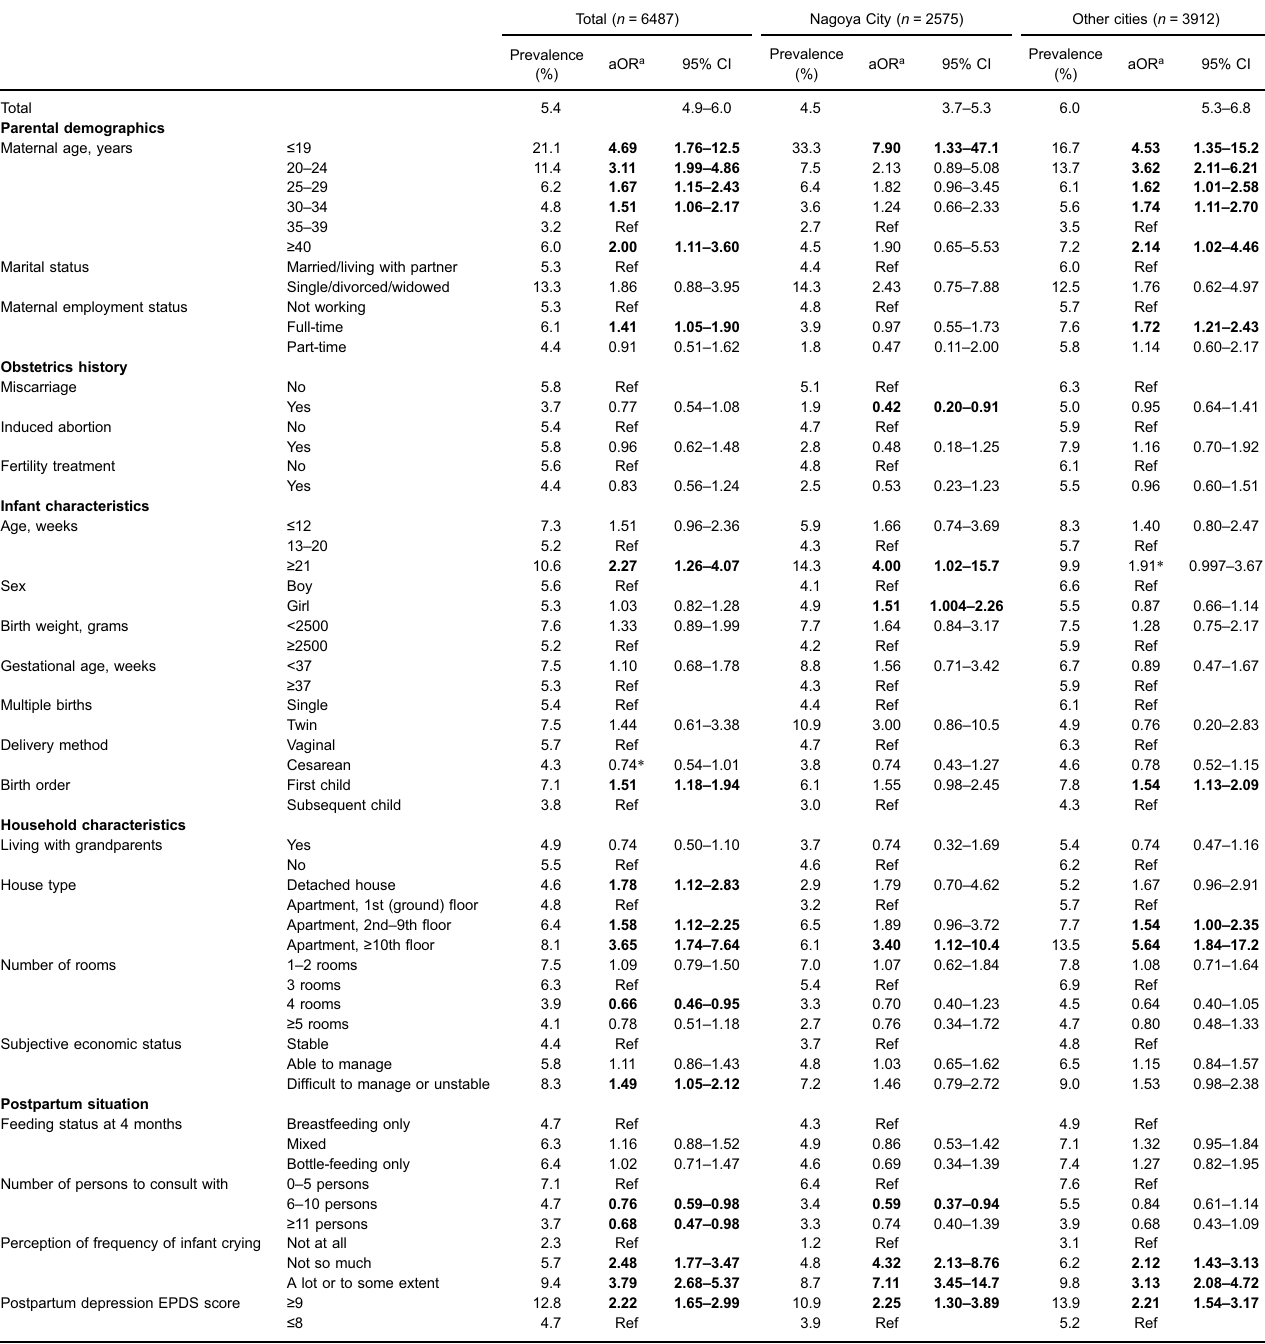
Table 5. Odds ratio of parental demographics, obstetrics history, infant ’ s characteristics, household characteristics, and postpartum situation for either shaking or smothering at 4 month of age, adjusted model, strati fi ed by Nagoya City and other